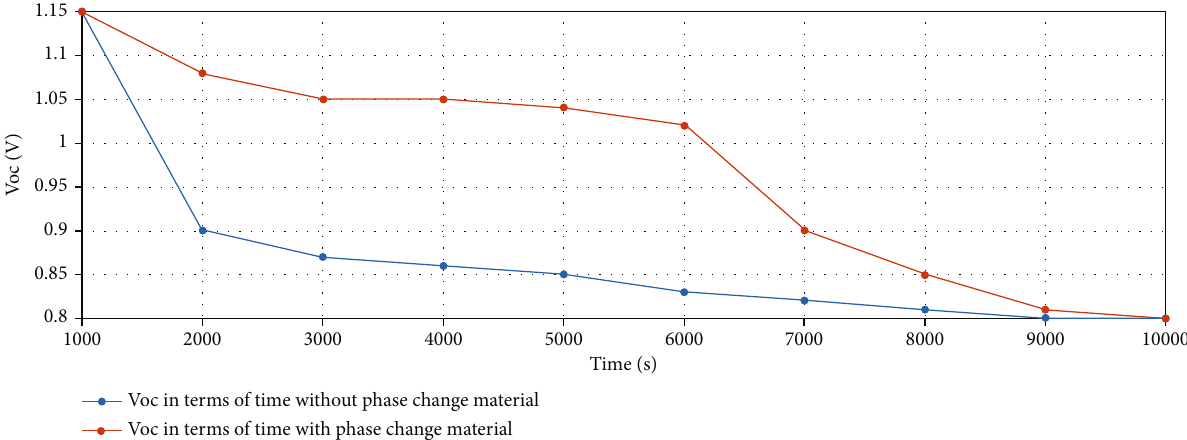
Figure 4: Open circuit voltage in terms of time, assuming a radiation intensity of 1000 watts per square meter in the state with and without the phase change material.